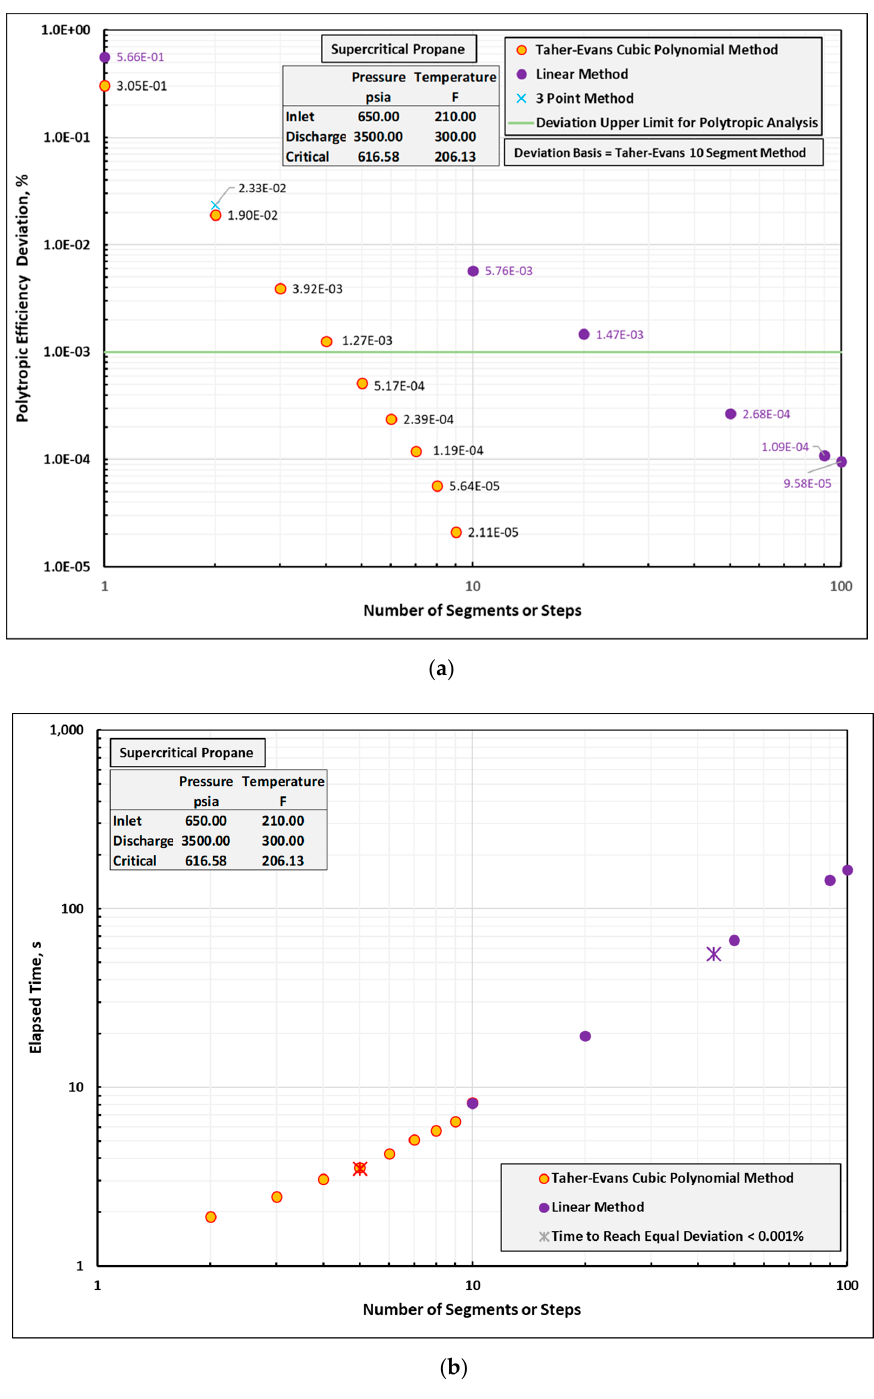
Figure A3. ( a ) Polytropic efficiency relative deviations for supercritical propane example. ( b ) elapsed time for supercritical propane example.